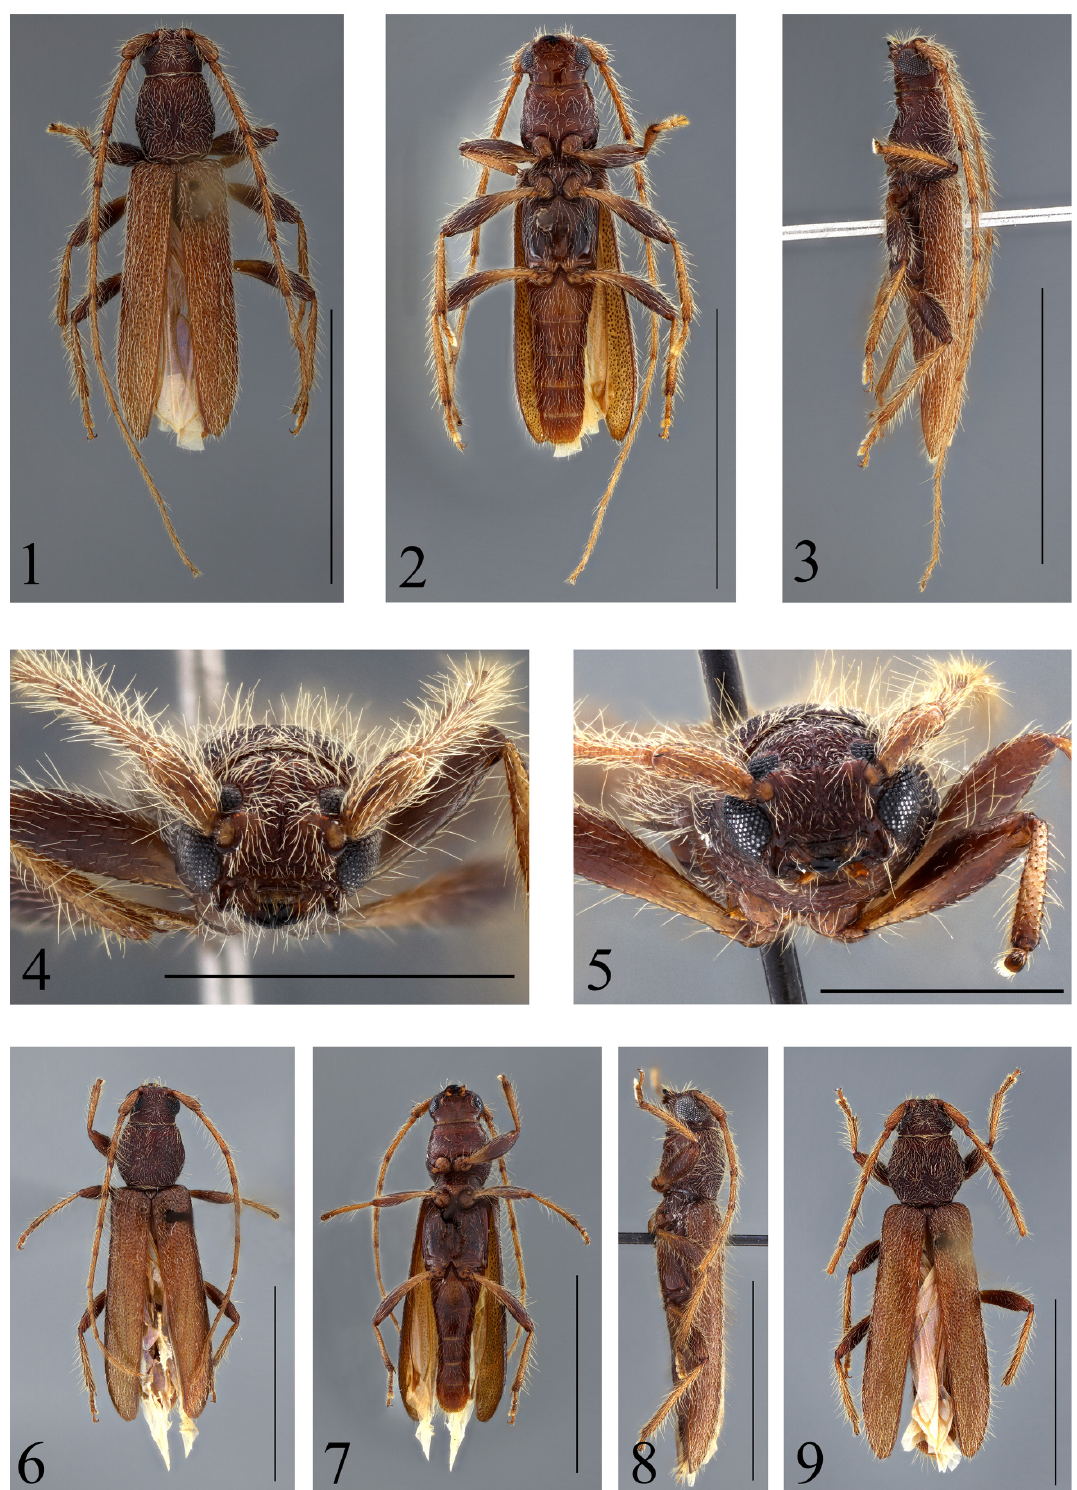
Figs 1–9. Ysachron pilosus gen. et sp. nov. 1–4 . Holotype, ♂ (MPUJ_ENT 0071150). 1 . Dorsal view. 2 . Ventral view. 3 . Lateral view. 4 . Details of head, frontal view. 5–8 . Paratype, ♀ (MPUJ_ENT 0071152). 5 . Details of head, frontal view. 6 . Dorsal view. 7 . Ventral view. 8 . Lateral view. 9 . Paratype, ♀ (MZSP). Dorsal view with sides of prothorax strongly rounded. Scale bars: 1–4, 6–9 = 0.5 cm; 5 = 0.25 94